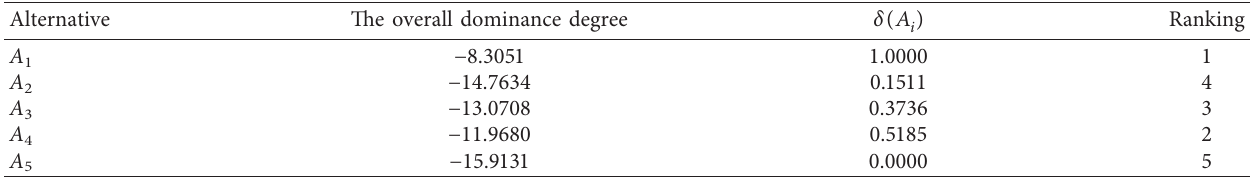
Table 4: Overall dominance degree for all